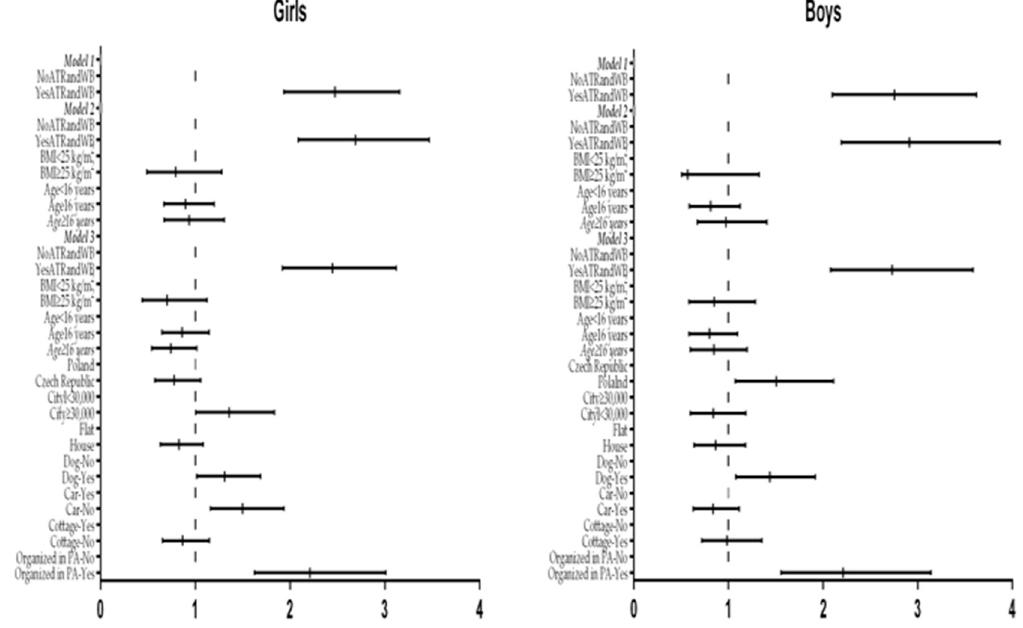
Figure 2. Odds ratios for meeting the weekly PA recommendation (five times 60 min of MVPA and concurrently three times 20 min of vigorous PA) in girls and boys according to compliance with the meeting of active travel recommendation along with greater well-being (YesATRandWB) or non- compliance with meeting the ATR and lower well-being (NoATRandWB).